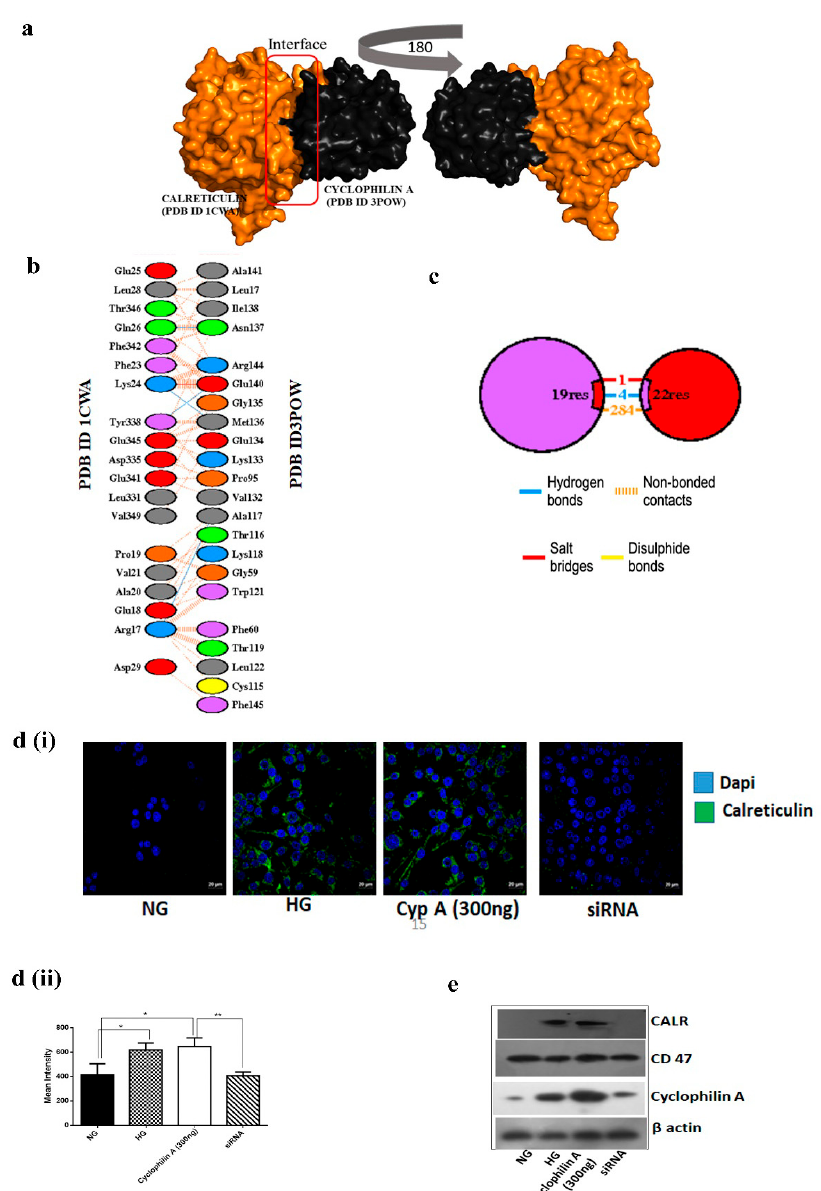
Figure 3. Cyclophilin A is associated with increased expression of CD 47 and is associated with reduced expression of the phagocyte receptor ligand calreticulin. The molecular association between Cyp A and known ligand receptors involved in efferocytosis was analyzed using molecular modeling studies. ( a ). Protein-protein docking analysis. CALR (PDB ID 1CWA) binds with Cyp A (PDB ID 3POW), with a high docking score of -219 and a ligand RMSD value of 51.69Å. ( b , c ). Analysis of amino acids between two candidate proteins, CALR and CypA. ( d ) (i and ii). Confocal images indicate an increased cellular-level expression of calreticulin in Cyp A-treated macrophages. ( e ). Western blot images displaying increased CD 47 expression over cell-surface calreticulin in Cyp A-treated macrophages. * p < 0.05, ** p < 0.01was considered significant. The data were compared using a one-way ANOVA, followed by multiple-comparison test using an SNK test.